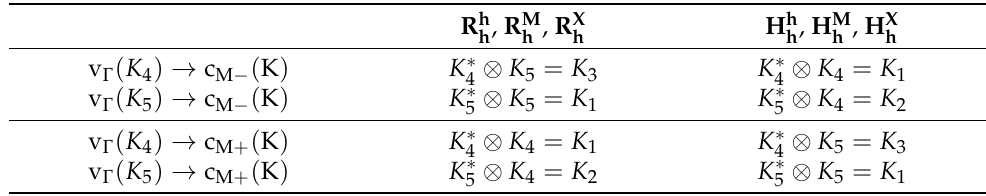
Table 7. Direct product of valence bands at the Γ point and conduction bands at the K point in the C 3 symmetry